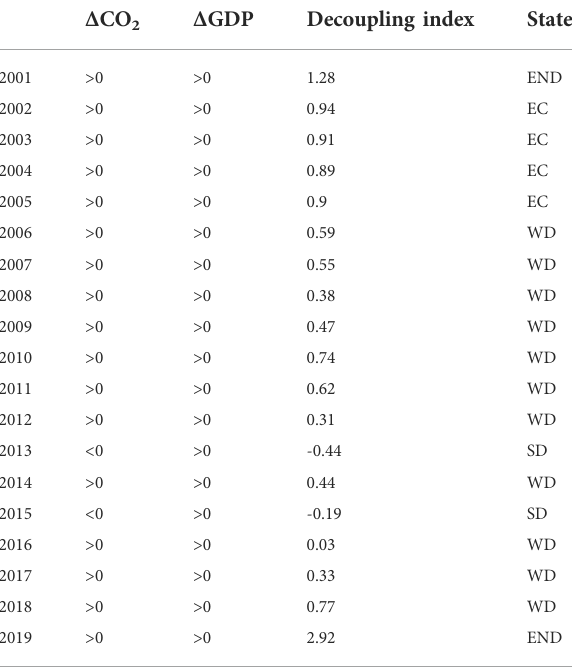
TABLE 5 Decoupling state of carbon emissions and economic growth in the